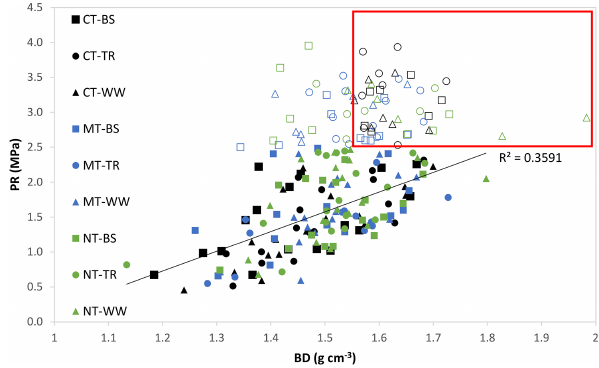
Figure 6. Saturated hydraulic conductivity (Ks) as measured in the two surveys (2019 and 2020). Different letters represent significant differences according to the post hoc Tukey test ( p < 0 . 05). Note: